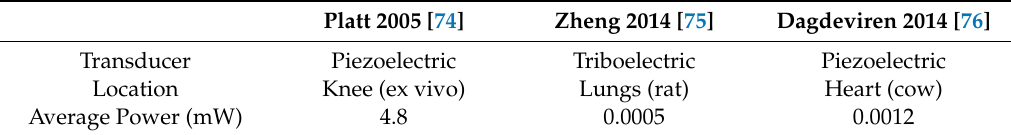
Table 4. Comparison of select kinetic energy harvesting